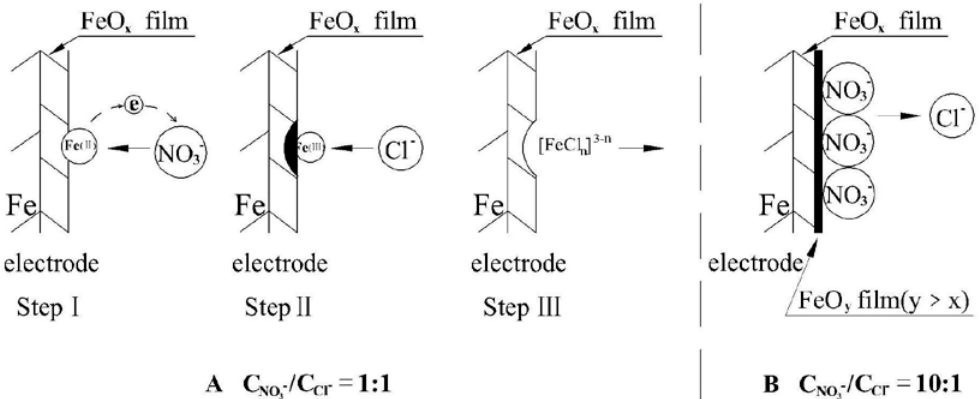
Figure 5. Schemata of the effects of NO 3 − ions and Cl − ions on the passive film of the iron electrodes ( A ) C NO3 − / C Cl − = 1:1; ( B ) C NO3 − / C Cl − = 10:1.